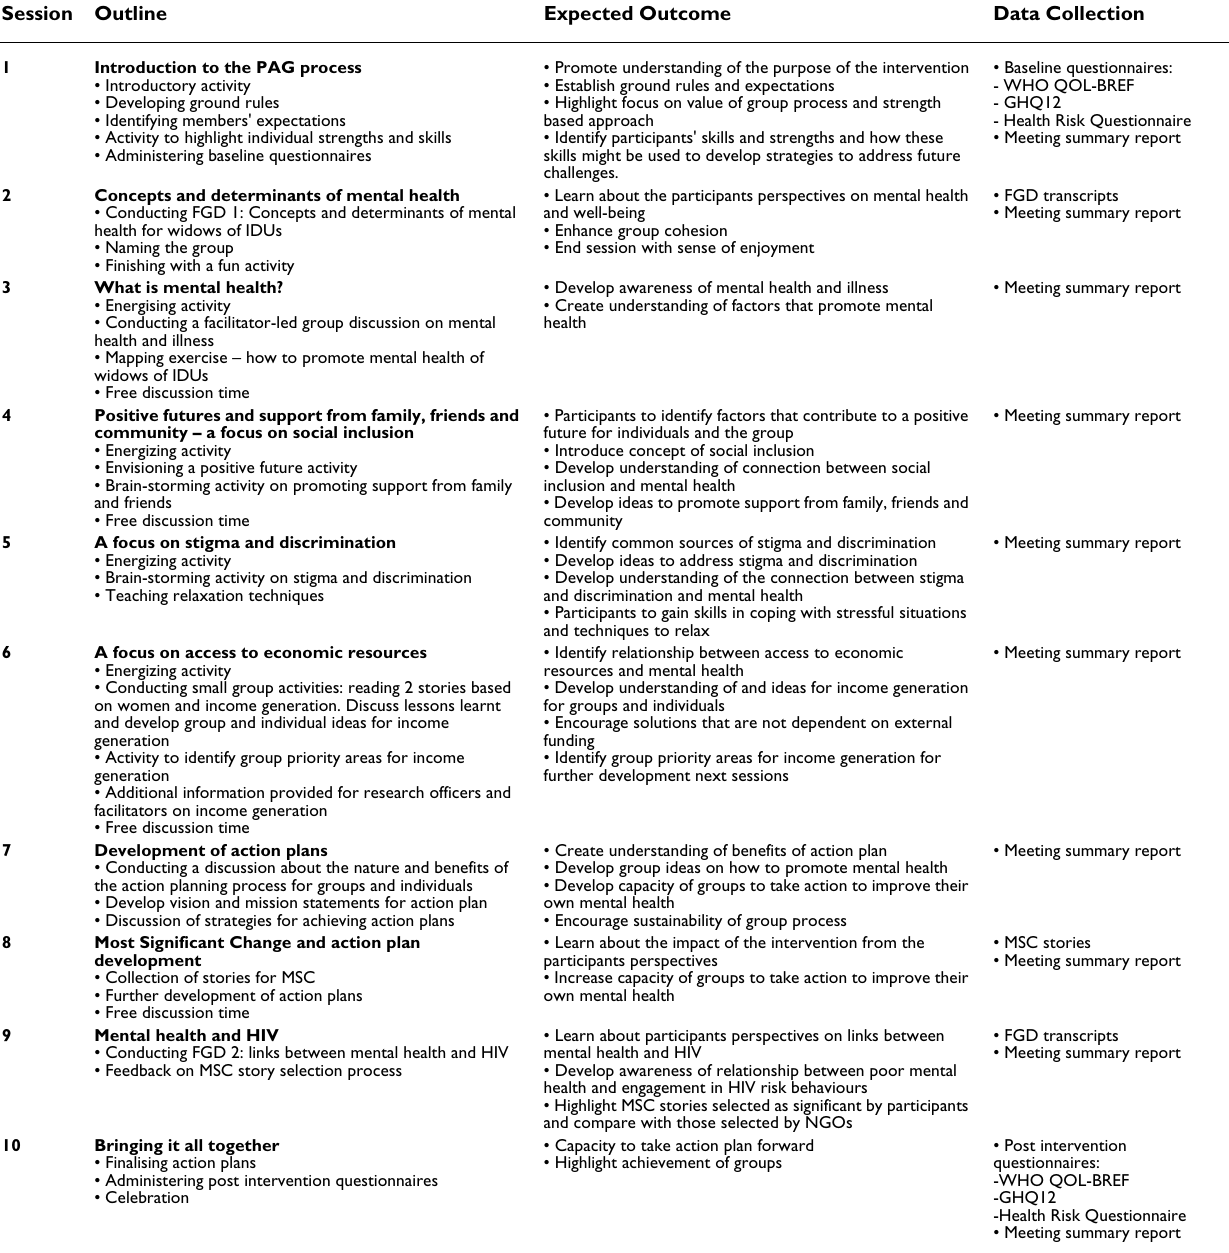
Table 1: Outline of the ten Participatory Action Group meetings for widows of IDUs Session